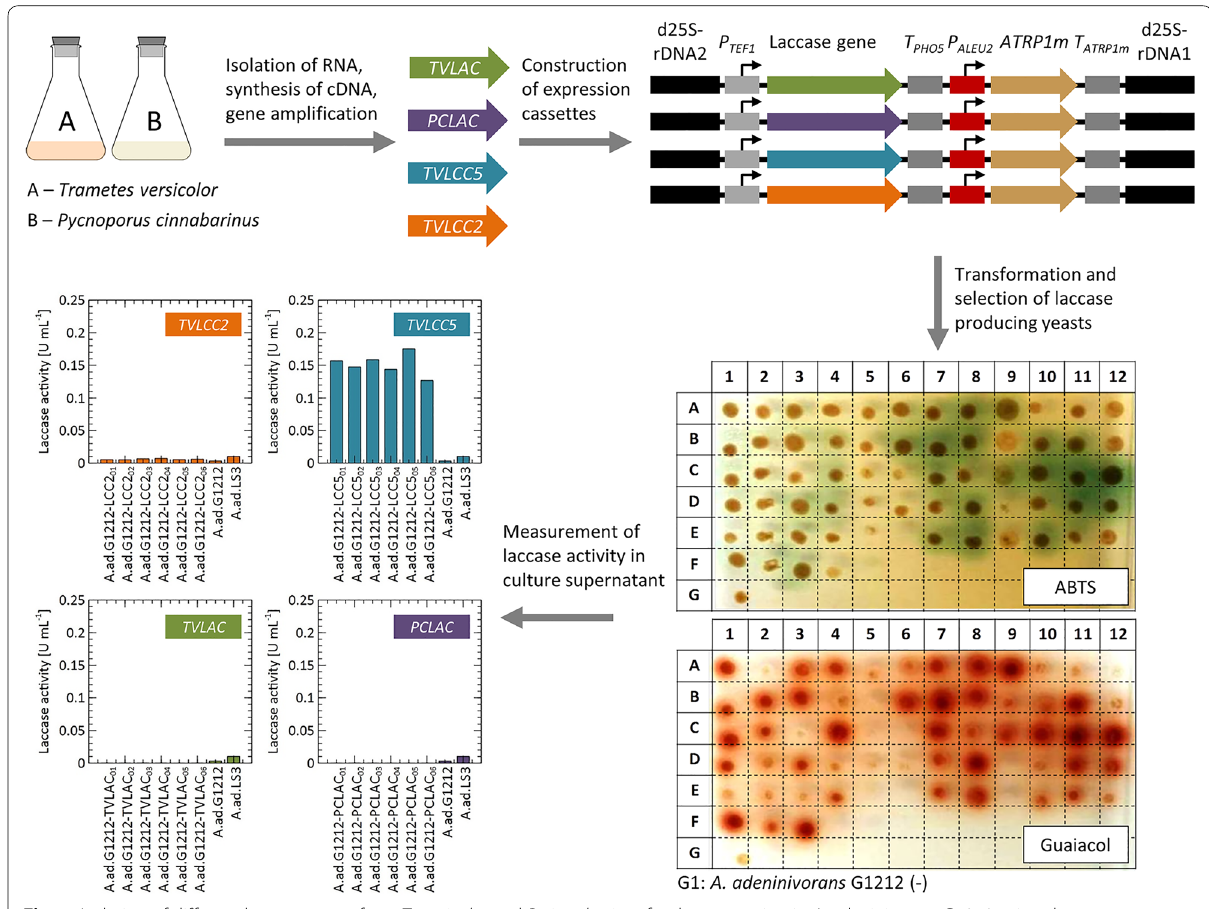
Fig. 1 Isolation of different laccase genes from T. versicolor and P. cinnabarinus for the expression in A. adeninivorans G1212 using the strong constitutive A. adeninivorans derived TEF1 promoter ( P TEF1 ) and the PHO5 terminator from S. cerevisiae ( T PHO5 ). Laccase gene expressing strains were preselected using ABTS and guaiacol agar plates. For the quantification of secreted laccase, the selected strains were grown in liquid minimal medium for 3 days. Laccase activity of the supernatant was estimated after centrifugation using ABTS as